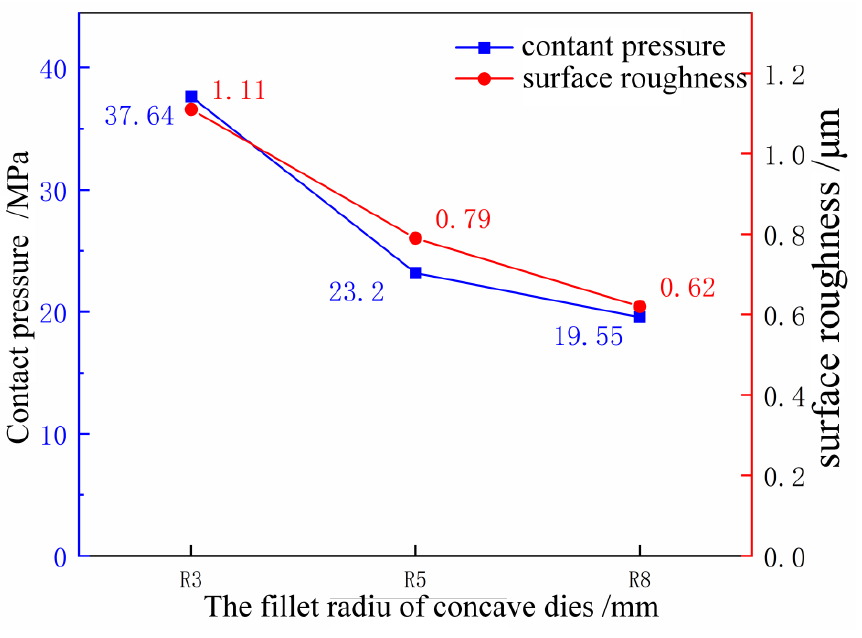
Figure 15. Contact pressure and surface roughness change curves at different die fillets.